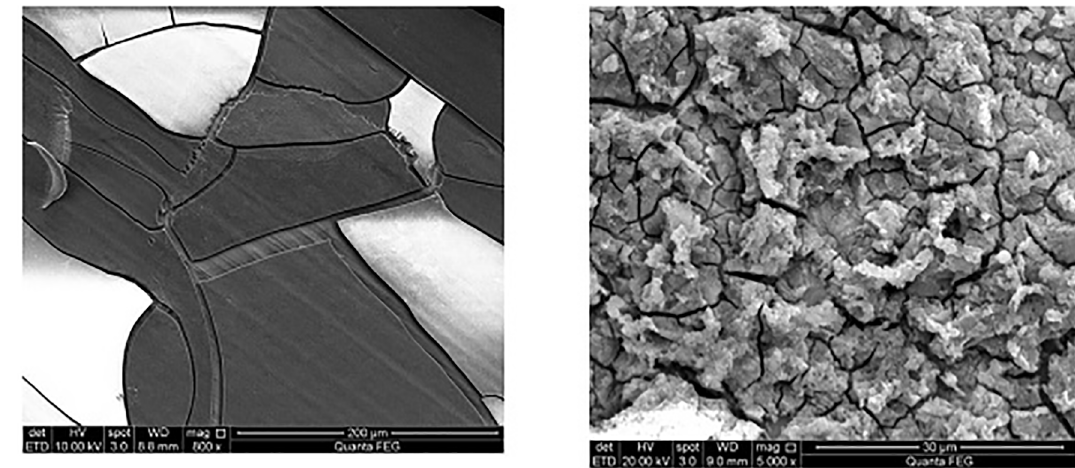
Figure 3 . Surface morphology of the uncoated AISI 304 steel after conducting the corrosion test.